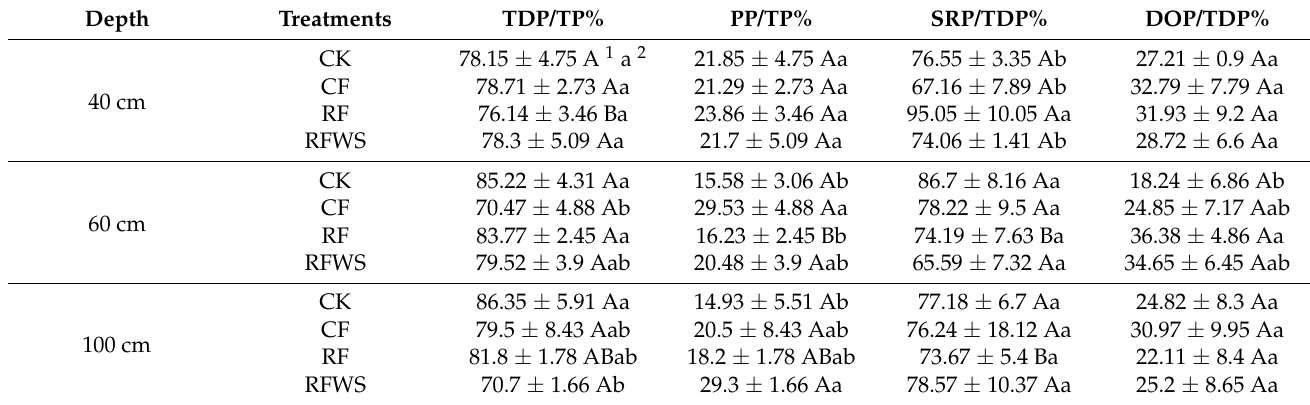
Table 5. The proportion of different forms of P in leaching